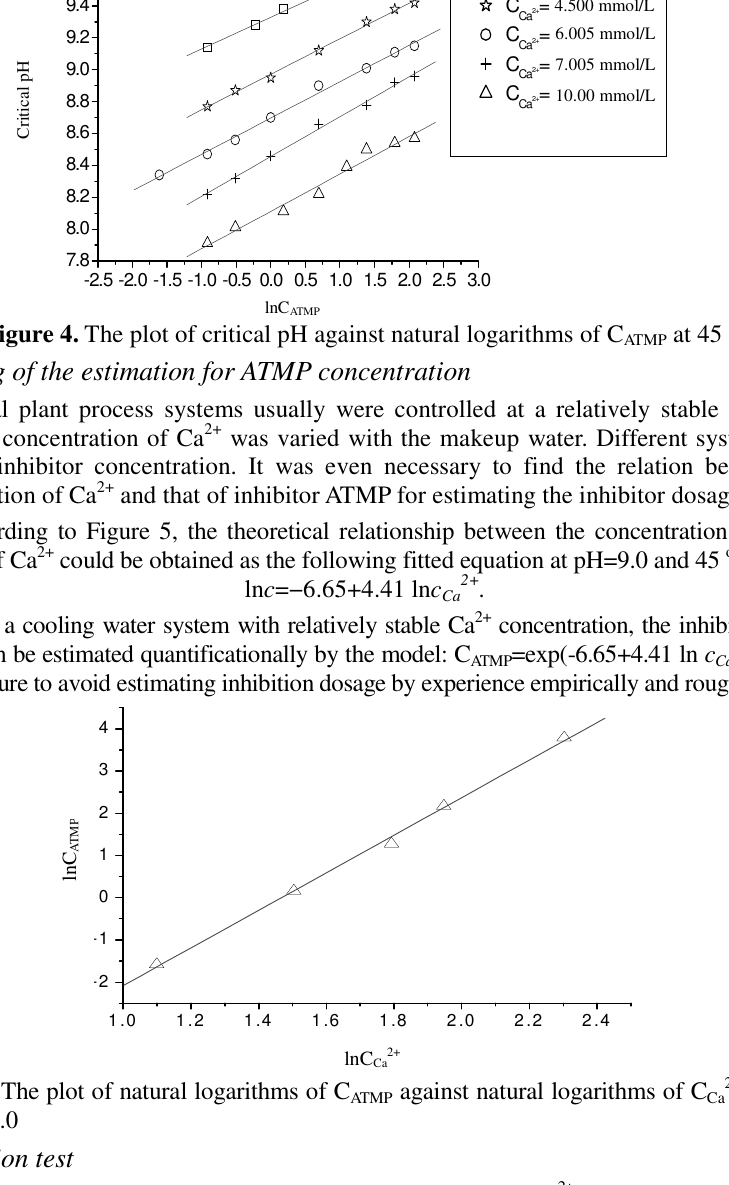
against natural logarithms of C Ca2+ at 45 o C ATMP